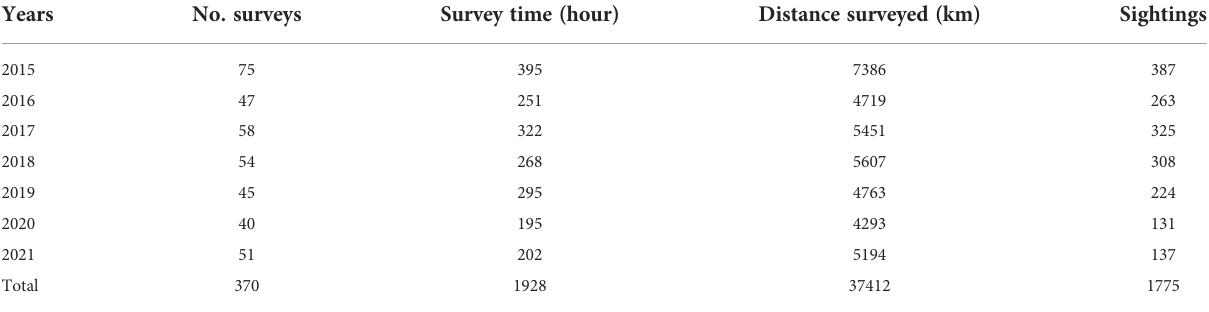
TABLE 1 Survey number, time, distance, and the sighting number of Indo-Paci fi c humpback dolphins recorded in the Pearl River Estuary from 2015 – 2021.